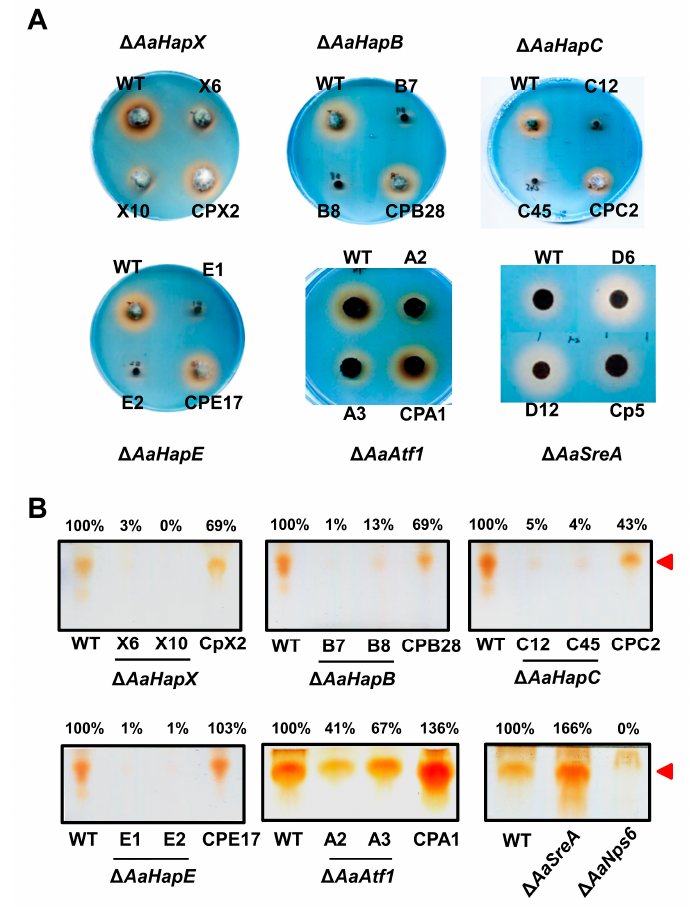
Figure 3. Siderophore production by A. alternata strains. ( A ) Fungal strains, including wild type (WT), deletion mutants ( ∆ ), and complementation strains (CP), were transferred by a pipette tip (10 µ L) to chromeazurol S-containing agar medium and incubated at 28 ◦ C for 3 to 5 days. The formation of an orange halo around the fungal colony indicates the production of siderophores. ( B ) TLC analyses of siderophores. Fungal strains were cultured in liquid MM for 5 to 7 days, and culture filtrates were mixed with FeCl 3 and Amberlite XAD-16 resin. Siderophores were eluted from the resin with methanol and analyzed by TLC. Relative abundance of the brown spots ( Rf ∼ 0.75, indicated by red arrowhead) were analyzed by Image J software V 1.54b by referring to the wild type.